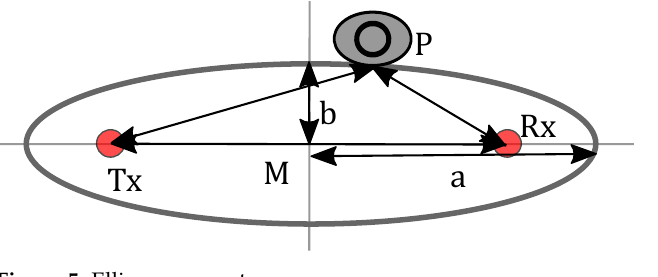
Figure 5. Ellipse parameters.